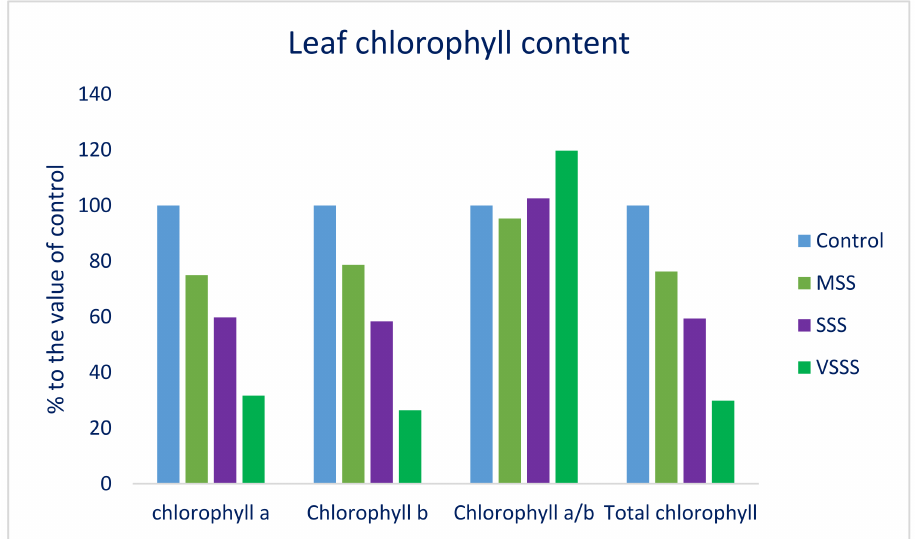
Figure 2. Impact on leaf chlorophyll content (% to the value of control) under four salinity levels: Control (no saline water); MSS = medium salinity stress (50 mM NaCl); SSS = severe salinity stress (100 mM NaCl); VSSS = very severe salinity stress (150 mM NaCl), in four selected A. lividus genotypes; ( n = 5). In the variety × salinity stress interactions, the chlorophyll a, chlorophyll b, chloro- phyll a/b, and the total chlorophyll ranged from 202.67 to 518.10 µ g · g − 1 ; from 95.06 to 323.91 µ g · g − 1 ; from 1.61 to 2.41 µ g · g − 1 ; and from 298.34 to 843.43 µ g · g − 1 , respectively.